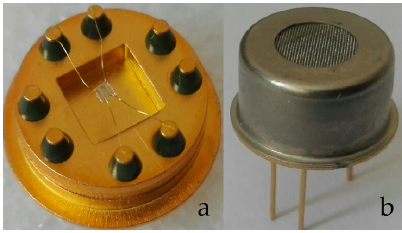
Figure 3. ( a ) Photo of the sensor assembled into the TO ‐ 8 can and ( b ) sensor with a protective